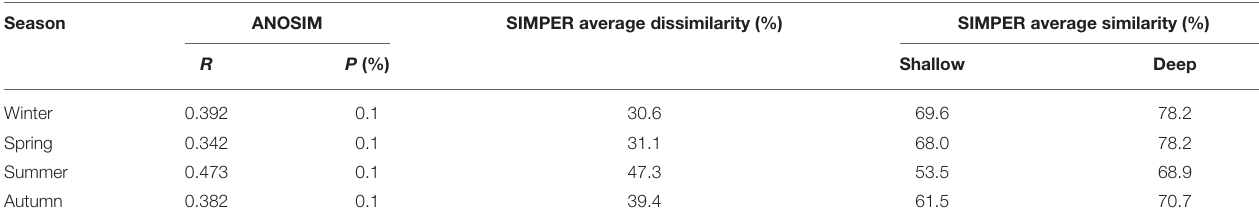
TABLE 3 | Comparison of the zooplankton community structures between the shallow and deep regions in the Yellow Sea according to ANOSIM ( R value and significance level) and SIMPER.